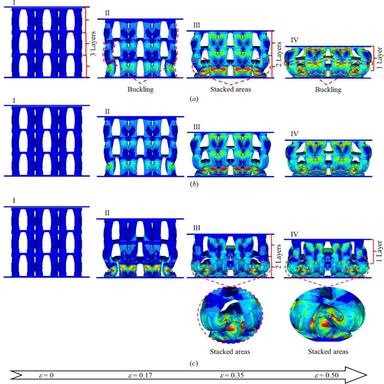
The deformation processes of CLL materials ( ¯ 0.261 = ): (a) CLL-HSSG350; (b) CLL-AA6063; (c) CLL-Ti6Al4V. (ε is nominal strain).